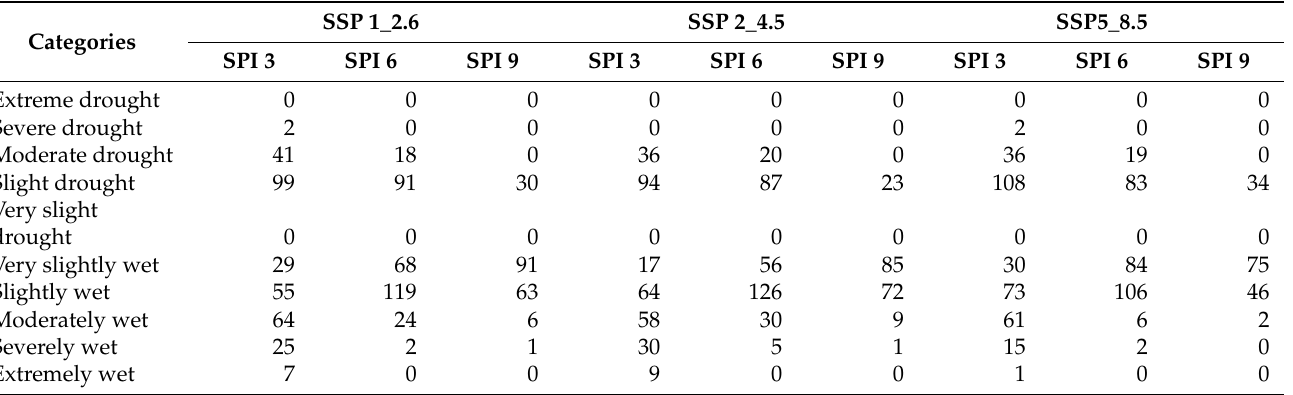
Table A1. Number of occurrences of drought and humidity in the different patterns of SPI using climate change data at Tri Ton